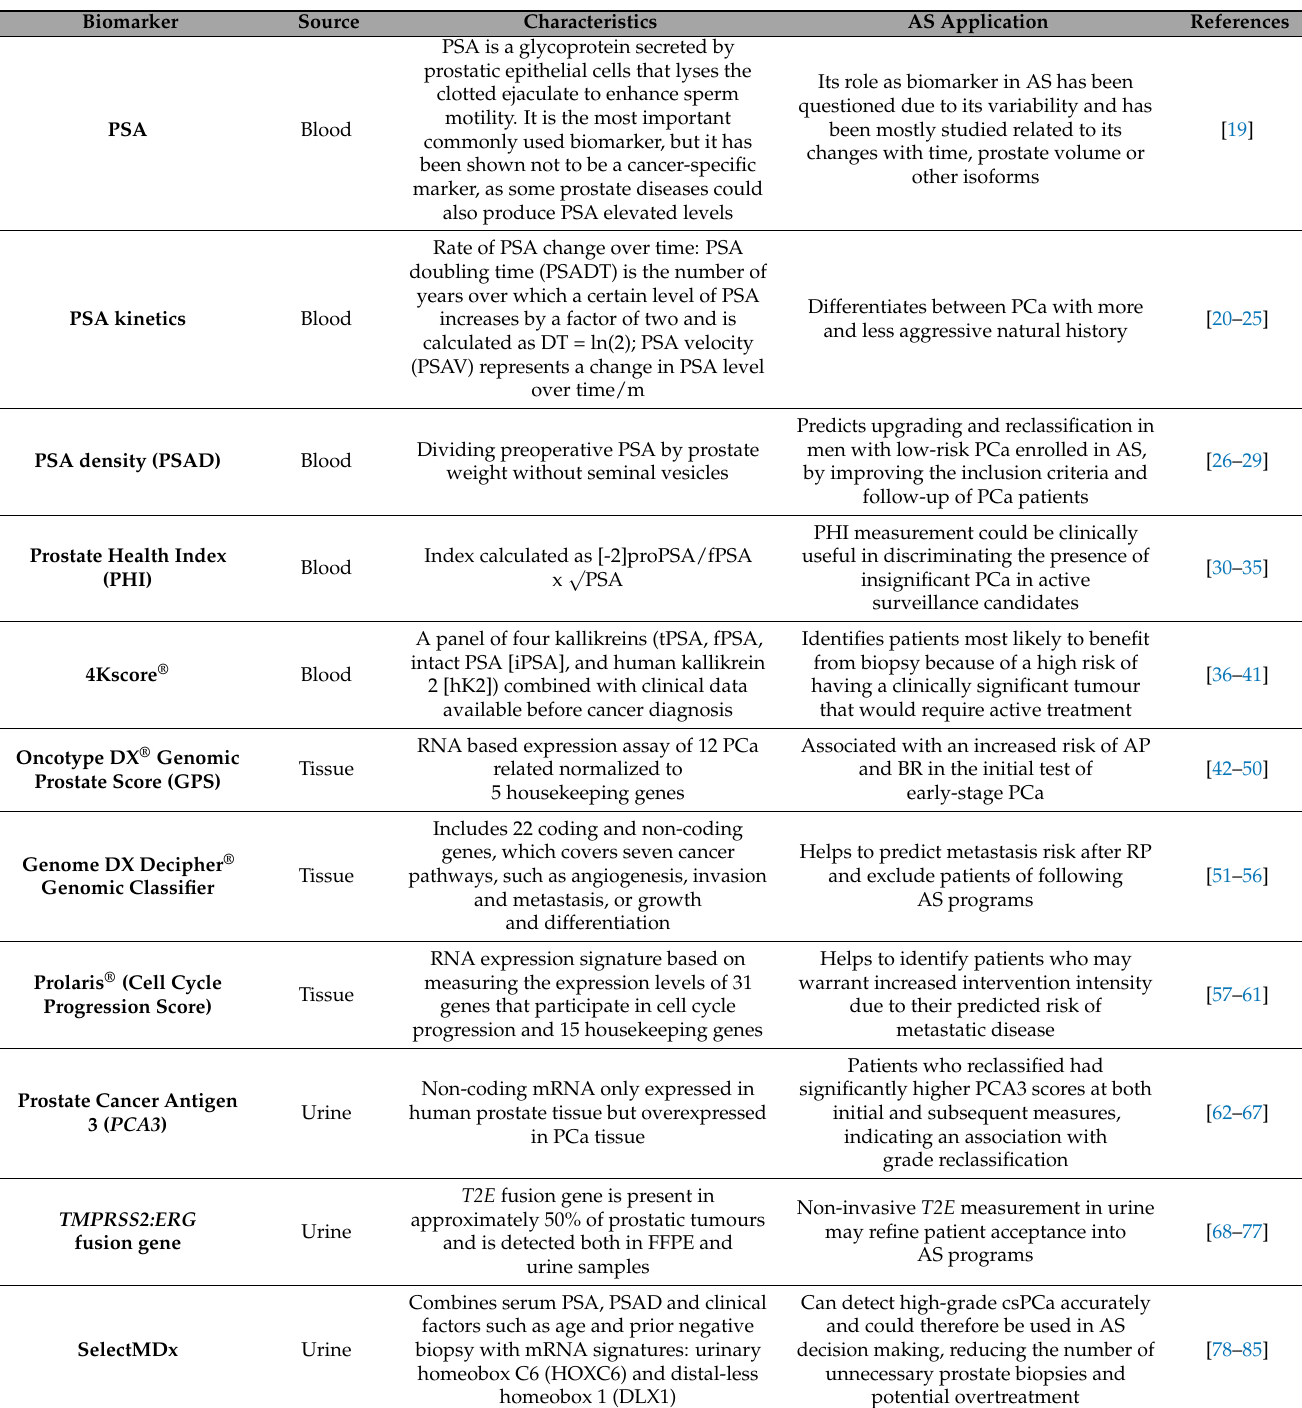
Table 1. Summary of clinically available biomarkers and tests with AS